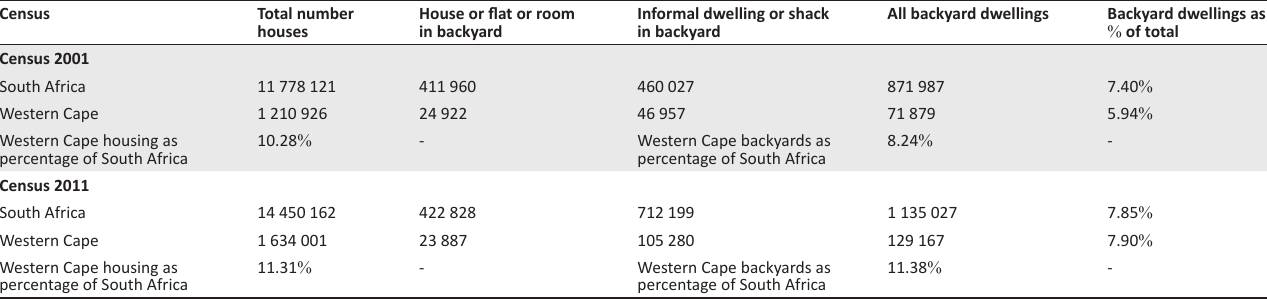
TABLE 1: Changes in the number of backyard dwellers between 2001 and 2011.